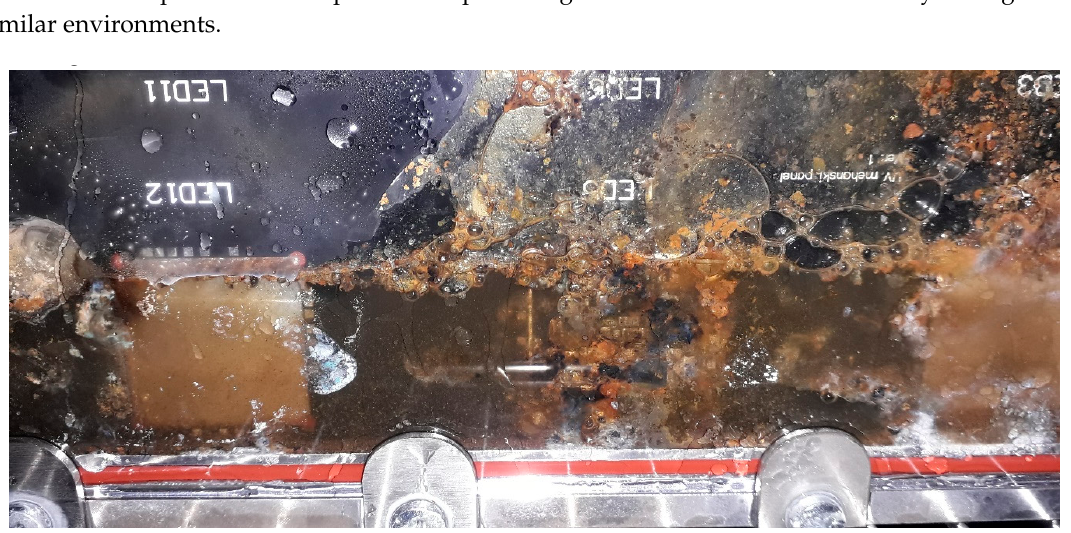
Figure 14. LEDs after degradation. ( a ) The front glass cover broke and the LED degraded severely. ( b ) The cover is cracked. However, it shows no other visible signs of degradation. ( c ) The cover is still intact and no degradation is visible.